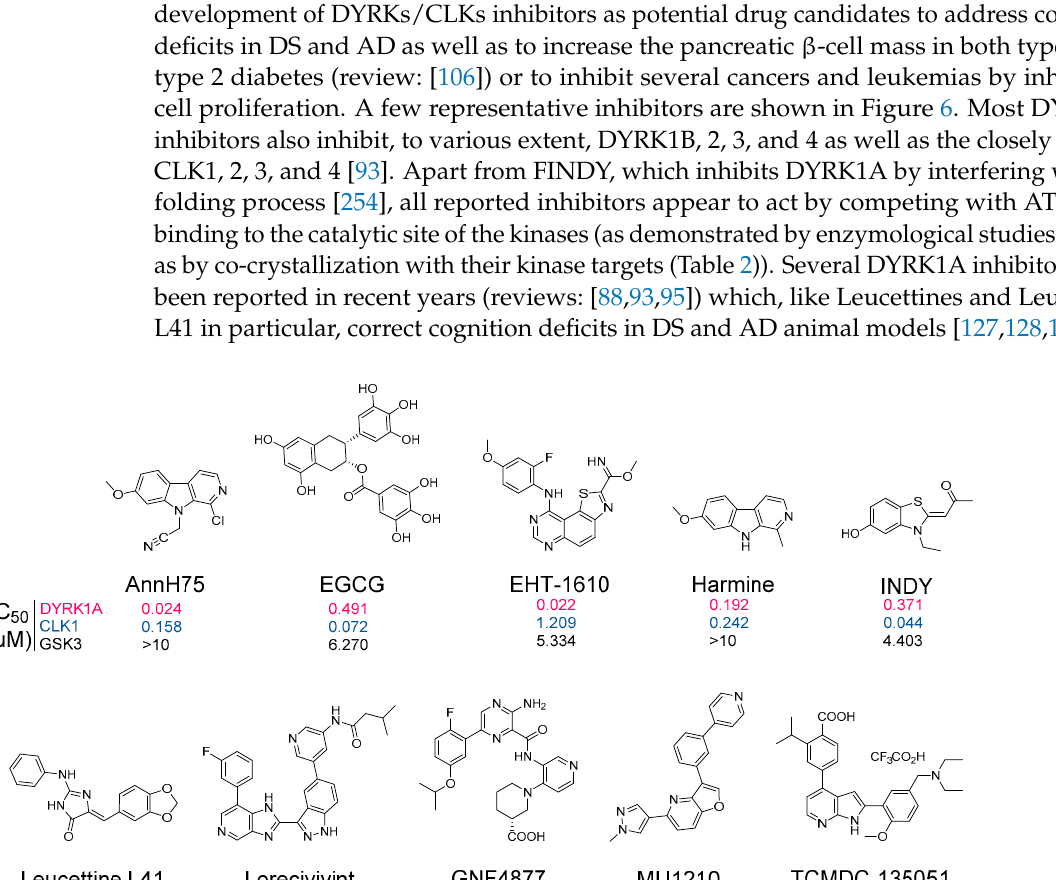
Figure 6. DYRK and CLK inhibitors. A few representative pharmacological inhibitors: AnnH75 [51], EGCG [255], EHT-1610 [55], Harmine [256], INDY [44], Leucettine L41 [43,257], Lorecivivint [258,259], GNF4877 [170,179], MU1210 [68], and TCMDC-135051 [251,252]. Numbers under each structure indicates IC50 values (expressed in µM) towards DYRK1A, CLK1, and GSK3 β (33PanQinase™ assay, Reaction Biology Corp.).